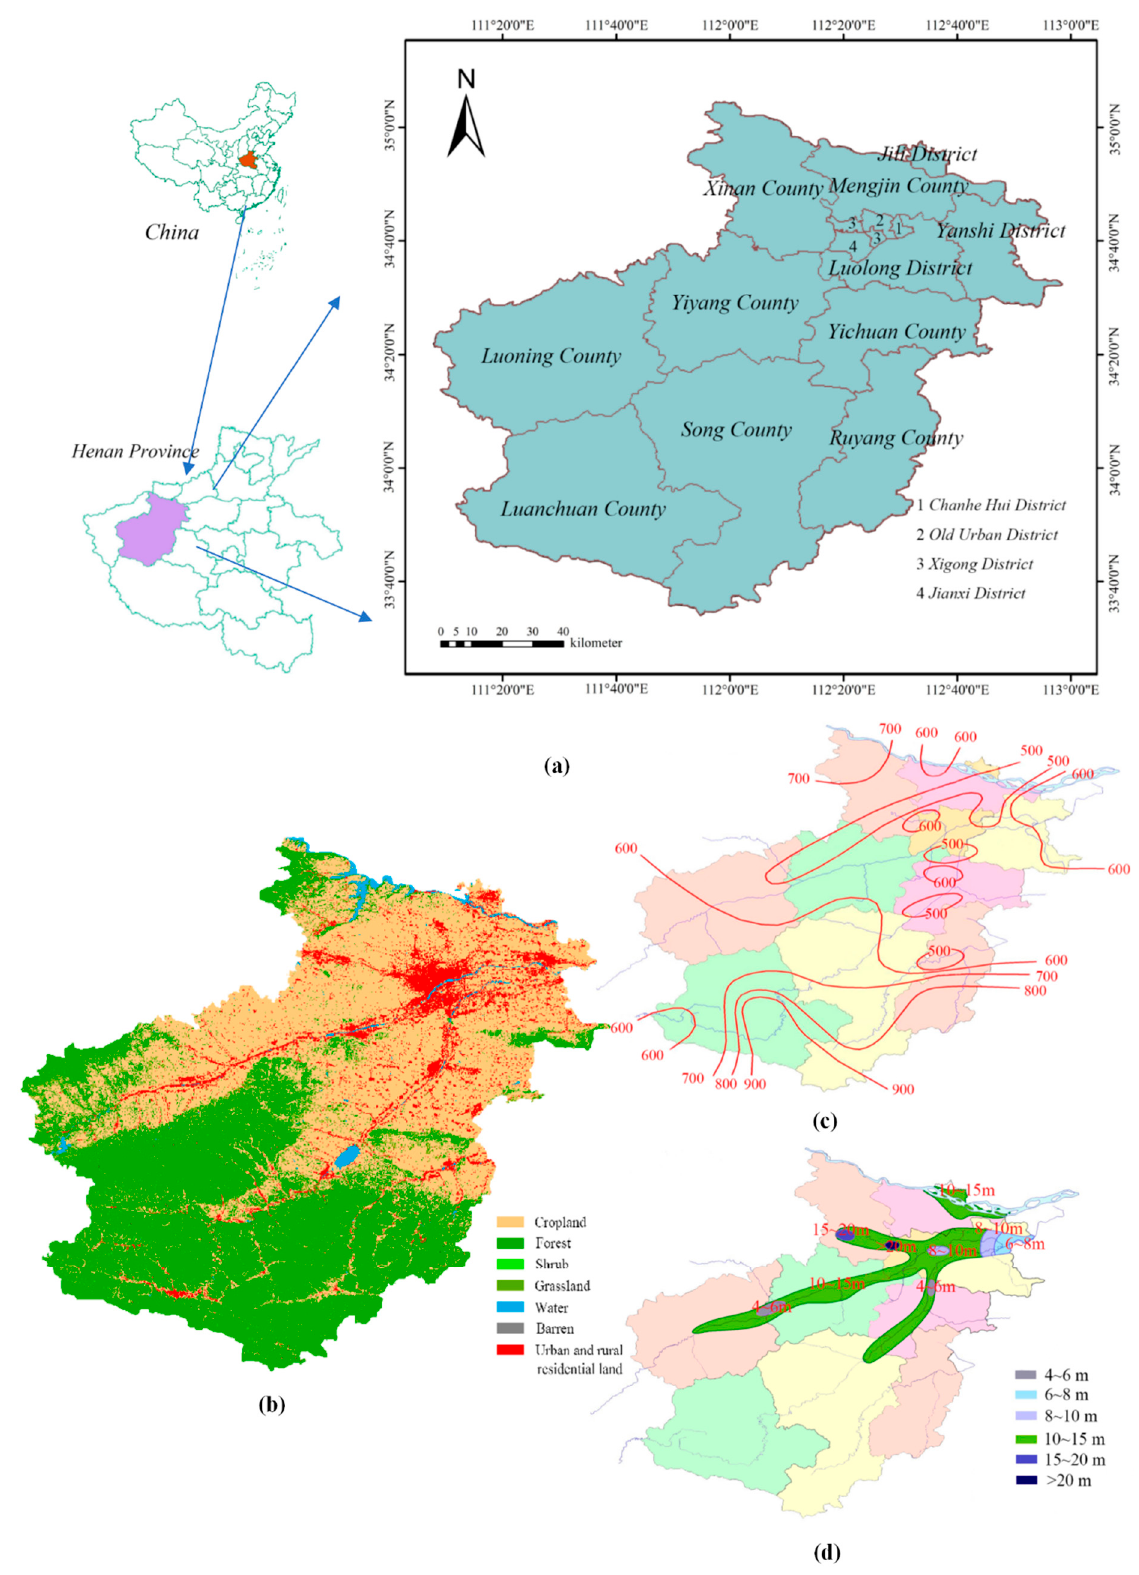
Figure 2. Geographical location of Luoyang ( a ), land type and distribution of Luoyang ( b ), isohyet of Luoyang in 2019 ( c ) and groundwater depth of Luoyang in 2019 ( d ).